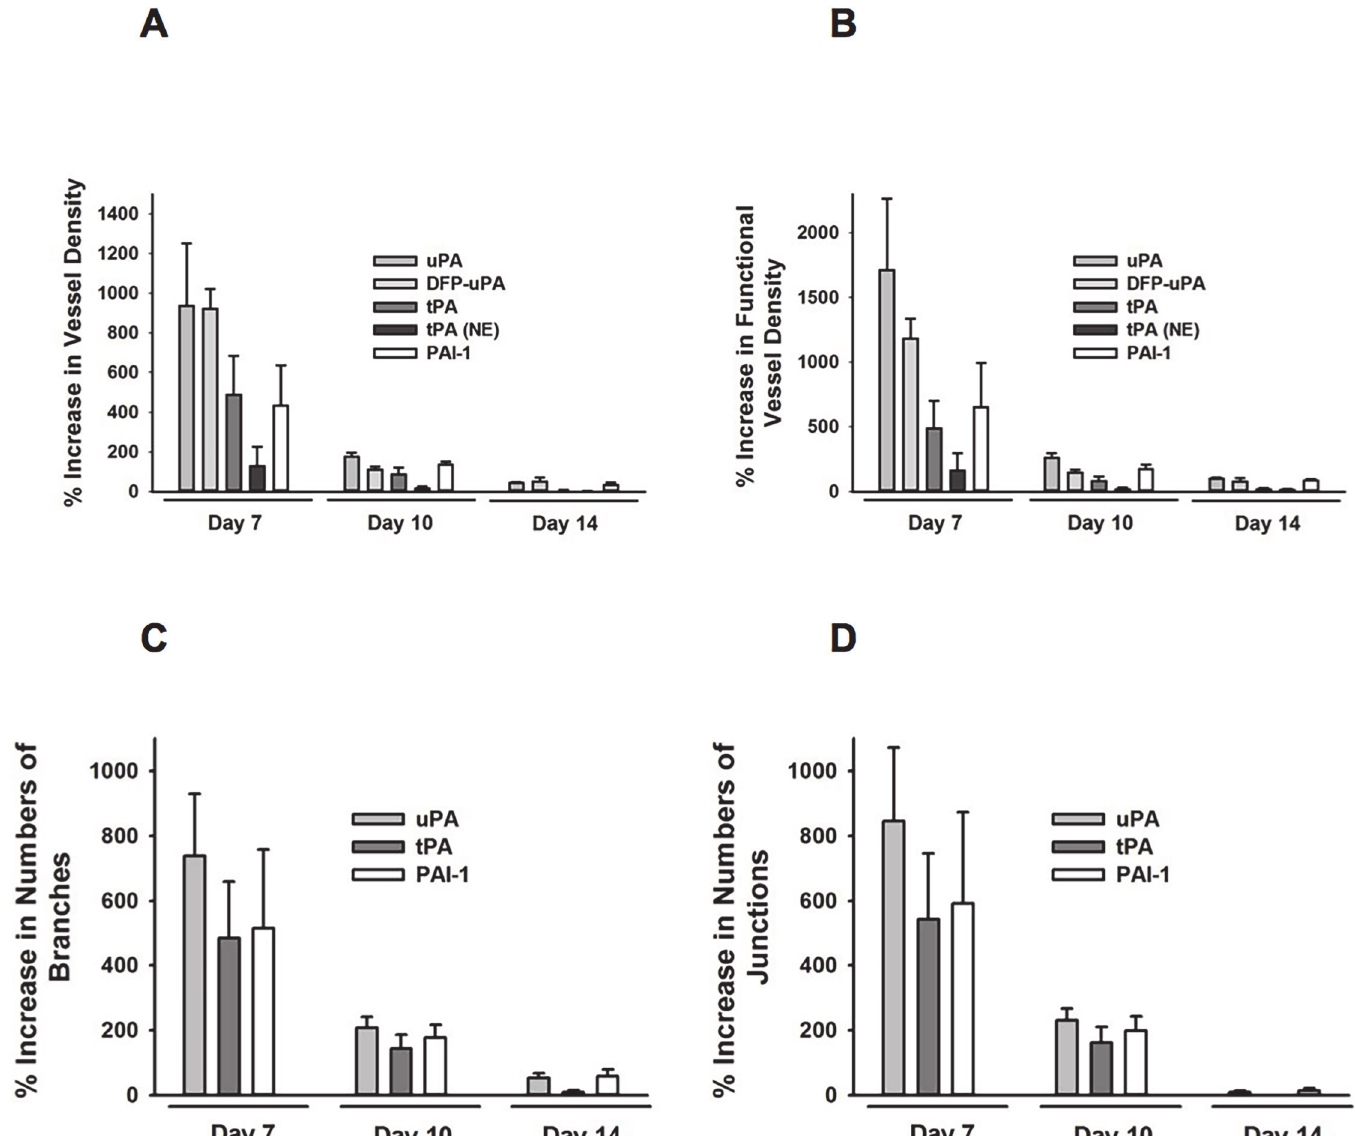
Figure 6. Effect of surface coating of implants with recombinant uPA, tPA, or PAI-1 on vascularization of PPE biomaterial. Vascularization of PPE implants, which were coated with recombinant uPA, tPA, or PAI-1 embedded in Matrigel, was analyzed by in vivo fluorescence microscopy in WT mice. Panels show results for the relative increase in absolute ( A ) and functional ( B ) vessel density within the implant as well as for the increase in the number of branches ( C ) and junctions ( D ) in the vessel network as compared to Matrigel-coated control implants (mean ± SEM for n = 5 –